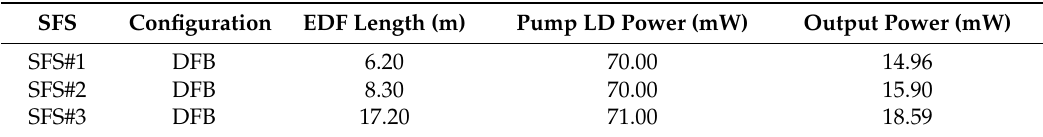
Figure 2. Output spectra of three SFSs with different EDF lengths at room temperature. Table 1. Specifications of the Three Tested